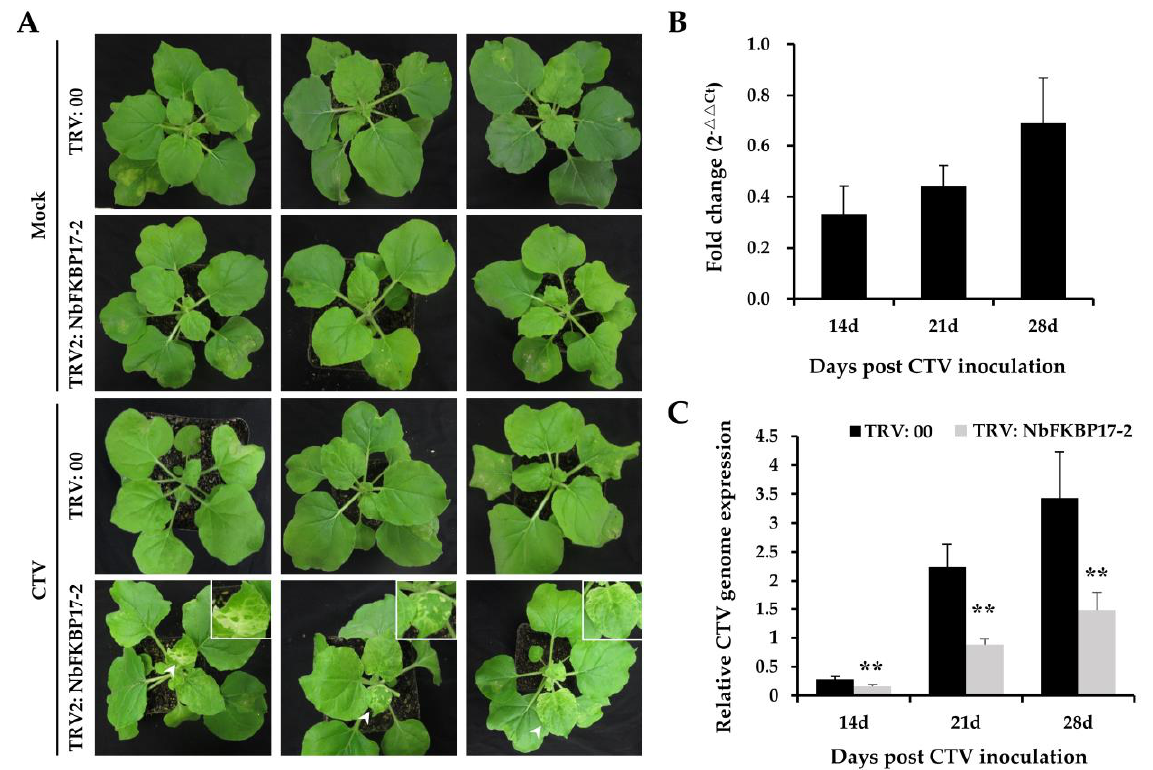
Figure 6. The phenotypes and relative expression levels of NbFKBP17-2 and citrus tristeza virus (CTV) genome in NbFKBP17-2 silenced Nicotiana benthamiana plants. ( A ) Phenotypes of TRV: 00 and TRV: NbFKBP17-2 pre-inoculated plants at 14 dpi of mock and CTV. ( B ) RT-qPCR analysis of NbFKBP17-2 mRNA expression in N. benthamiana leaves. The expression levels of NbFKBP17-2 mRNA were normalized to NbActin mRNA levels. ( C ) RT-qPCR analysis of relative expression levels of CTV genome in N. benthamiana leaves. Values were means ± SD from three independent experiments. Asterisks denoted significant differences in Student’s t -test between the two treatments (two-sided, ** p < 0.01).